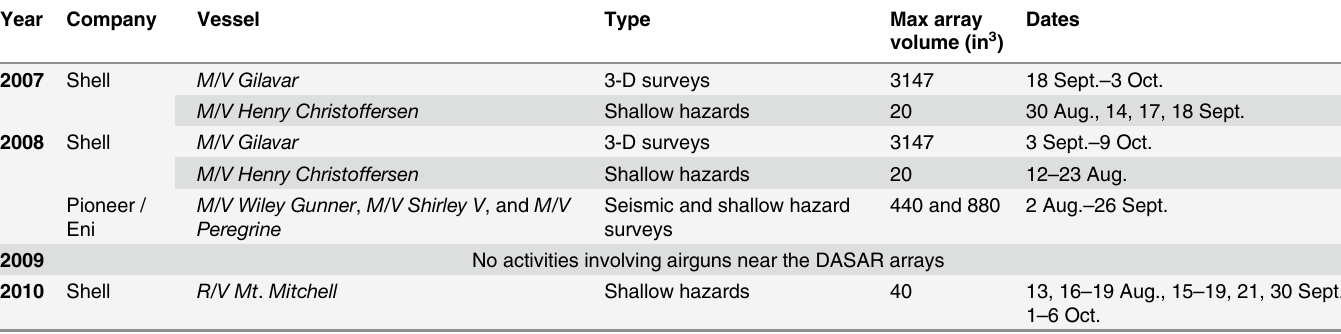
Table 2. Airgun operations taking place within or near the DASAR arrays in 2007 – 2010.